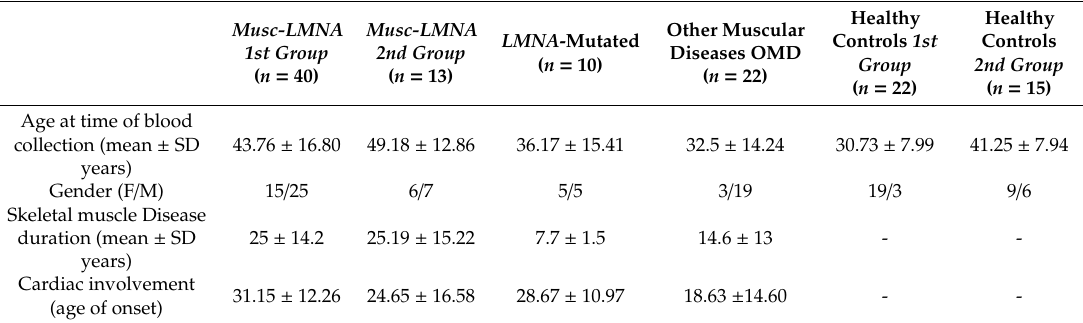
Table 1. Clinical data of patients included in the